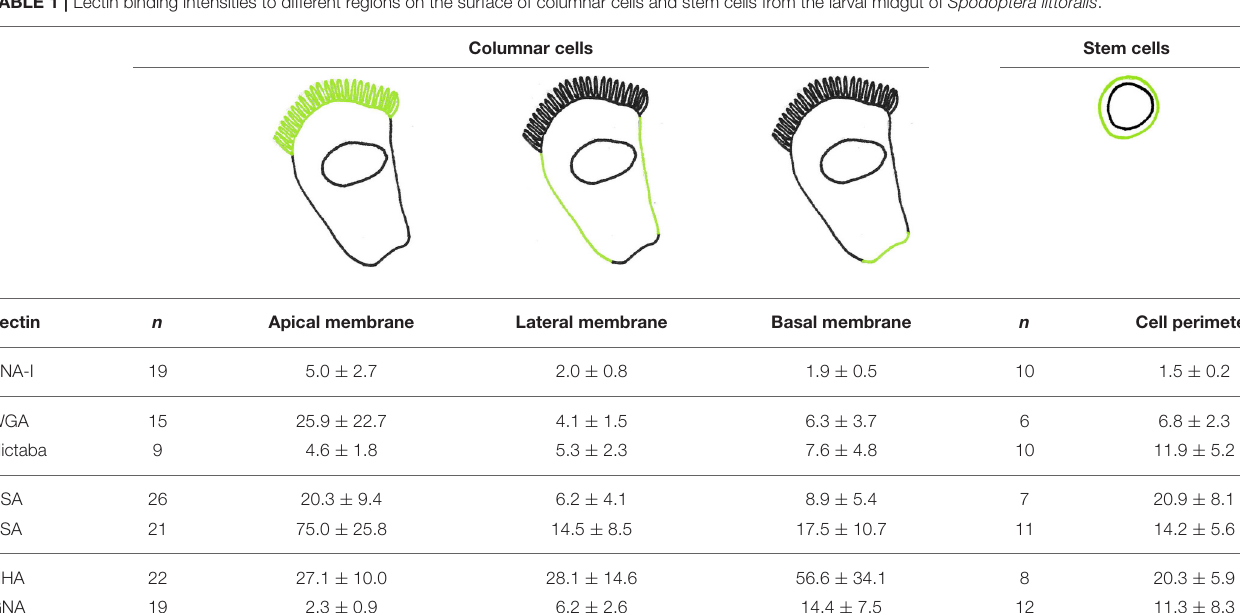
Valuesaremeanpixelintensitiesmeasuredinthemanuallyselectedapical(microvillar),basalandlateralzoneofthemembraneofcolumnarcellsaswellasinthecellmembrane(perimeter) ofstemcells.Pixelintensitiesareaverageratiosoffluorescenceintensitiesinthegreen-indicatedregionsonthesurfaceofthemidgutcellsrelativetobackgroundfluorescence ± standard